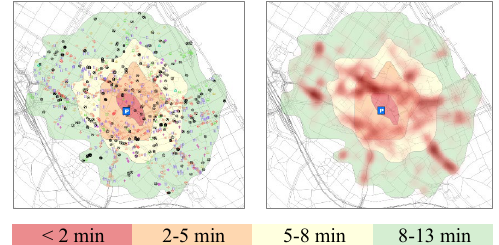
Figure 3: Reachability analysis for car park ‘Kronberger Hof’ In order to account this analysis, we calculate the real walking distances between every POI k and every starting point i . Based weight r ki . Second, the variable o j represents weighted opening